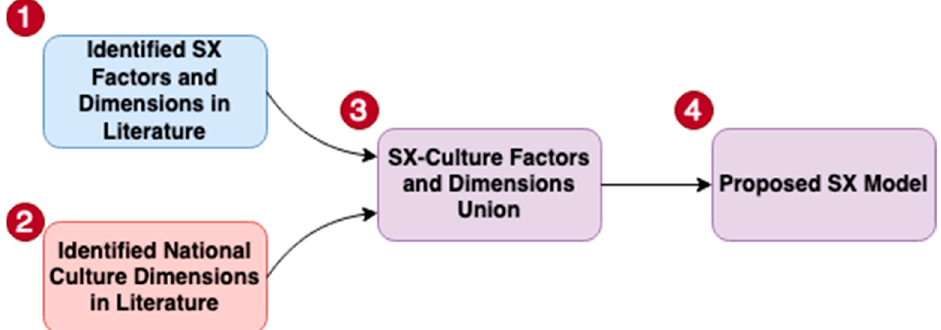
Figure 2. Student eXperience model development stages.